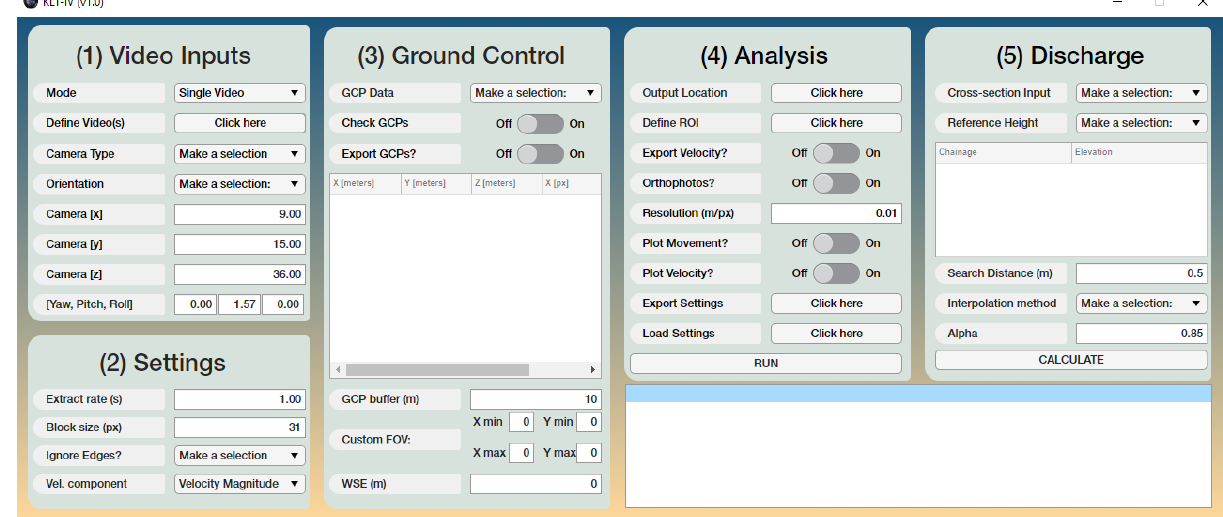
Figure 1. Graphical user interface (GUI) of KLT-IV version